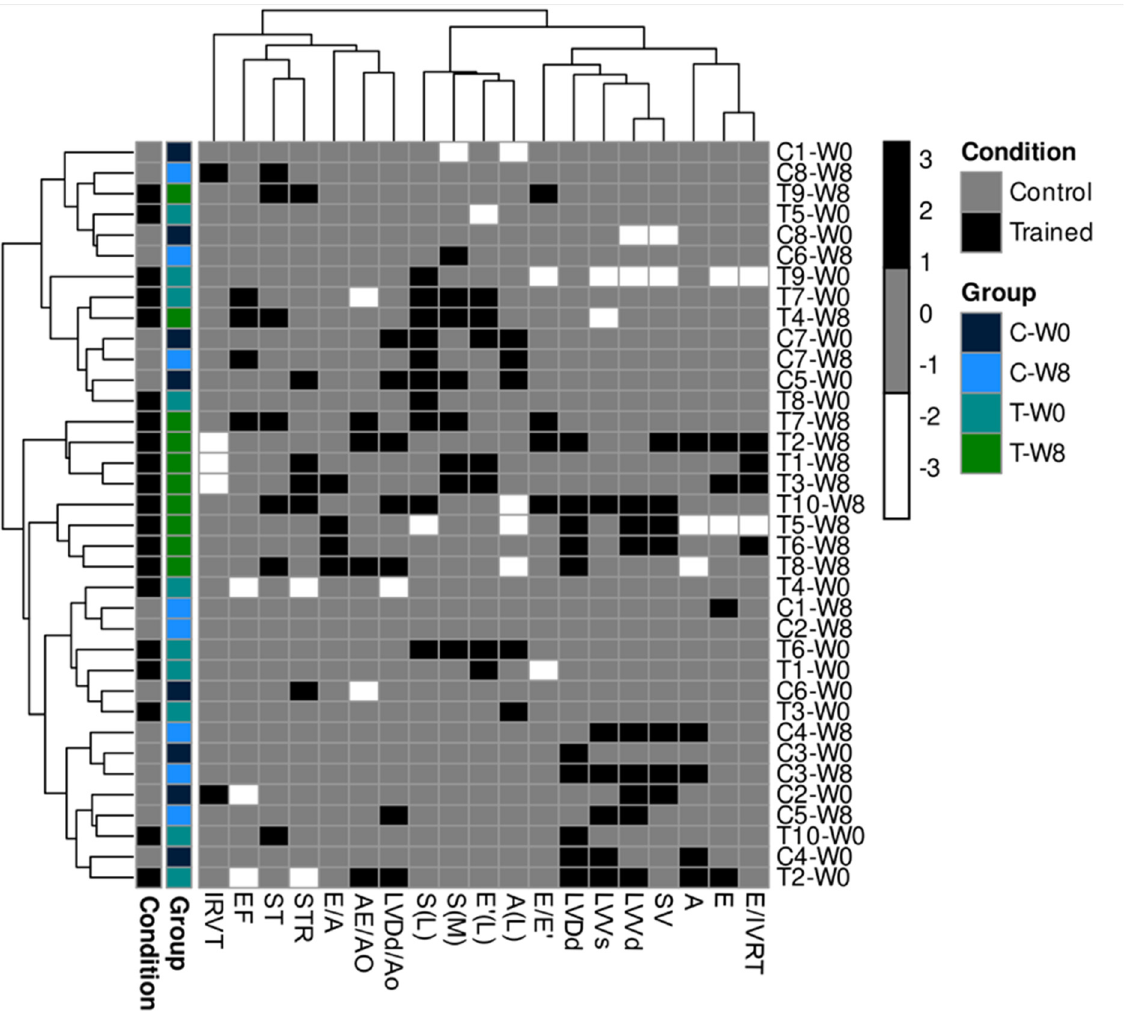
Figure 7. Heatmap of echocardiographic variable scores of dogs submitted to eight weeks of the endurance training program. The color gradient represents score magnitude; the blacker, the more massive the echocardiographic response.